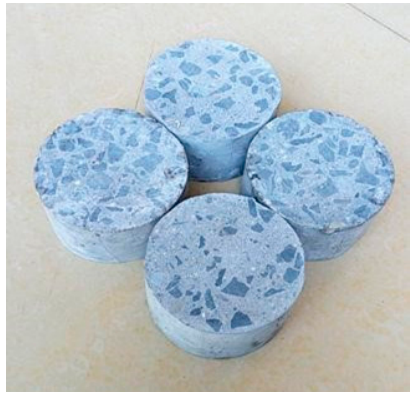
Figure 2. The processed cylinder specimens.